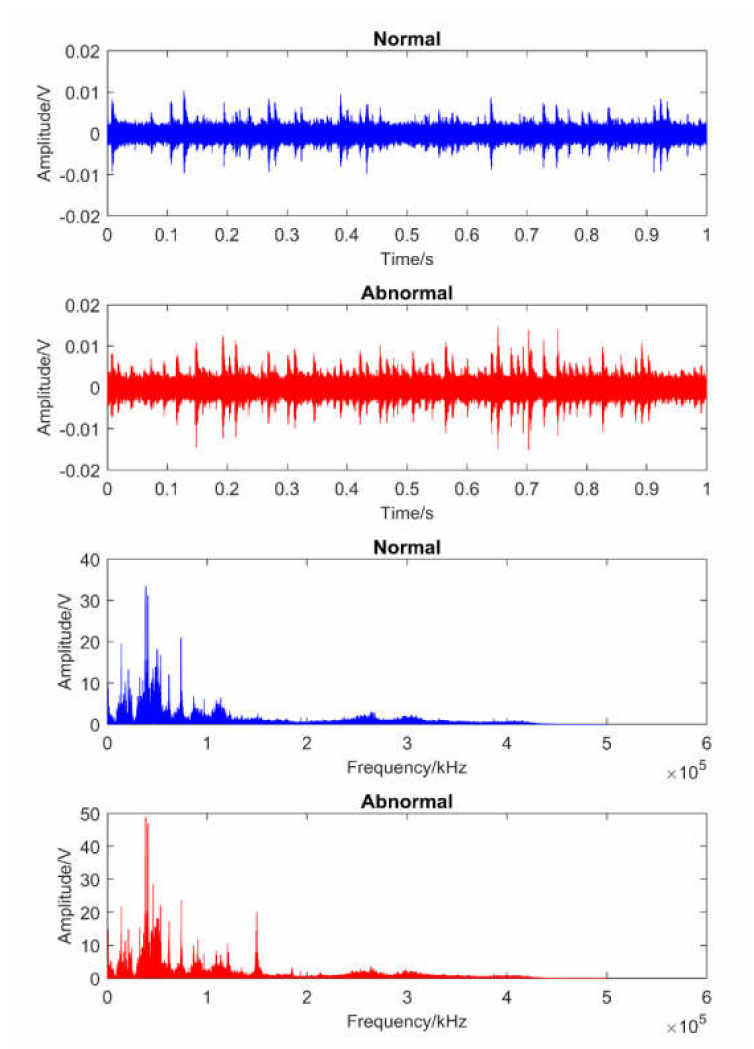
Figure 7. The illustration of the obtained AE signals in dataset 1 over the time and frequency